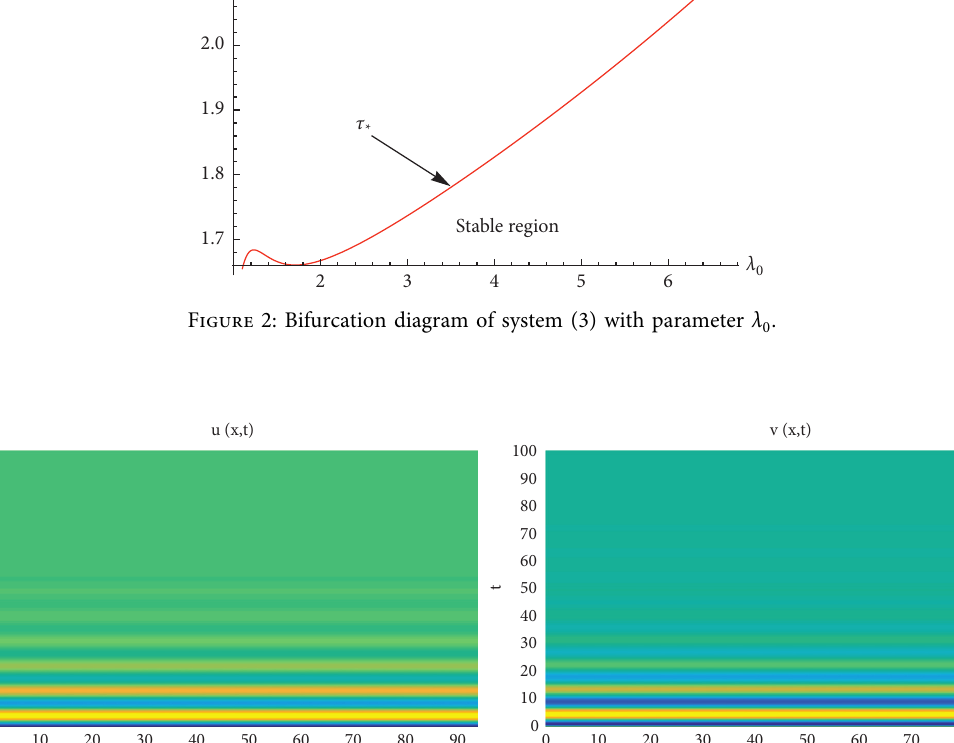
Figure 3: Numerical simulations of system (3) with τ � 2 and the initial condition at ( 2 . 1 + 0 . 0001 sin x, 0 . 5 − 0 . 0001 cos x ) .